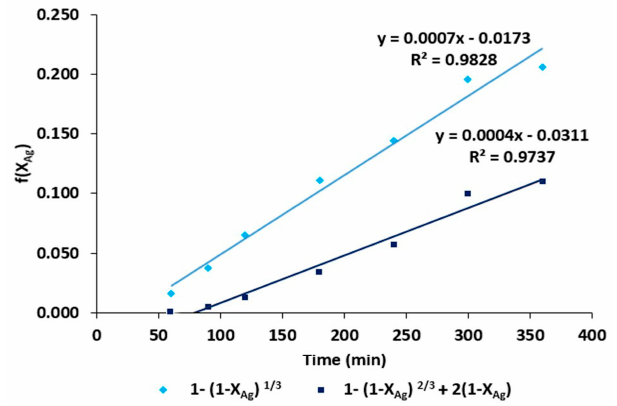
Figure 6. Comparison of the chemical control model vs. the model by transport of matter in silver leaching using the Ag ‐ S 2 O 32 − ‐ O 2 ‐ NaOH system.